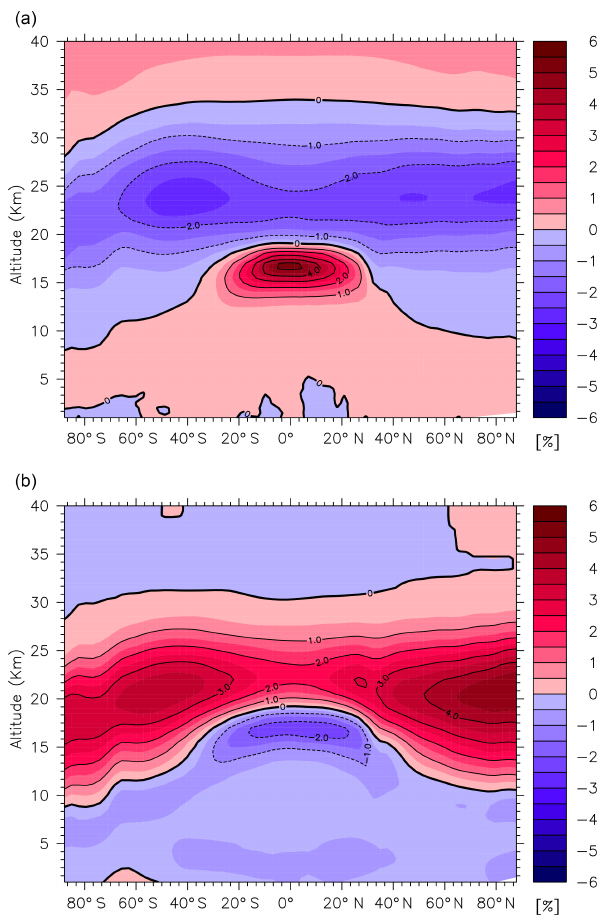
Figure 12. Impact of the results from this work in a global atmo- spheric chemistry model (EMAC). The contours indicate the per- centage change in the predicted mixing ratios (zonal and annual average) of HNO 3 (a) and NO x (b) , which result from the new pa- rameterisation of k 5 compared to the IUPAC and JPL recommended